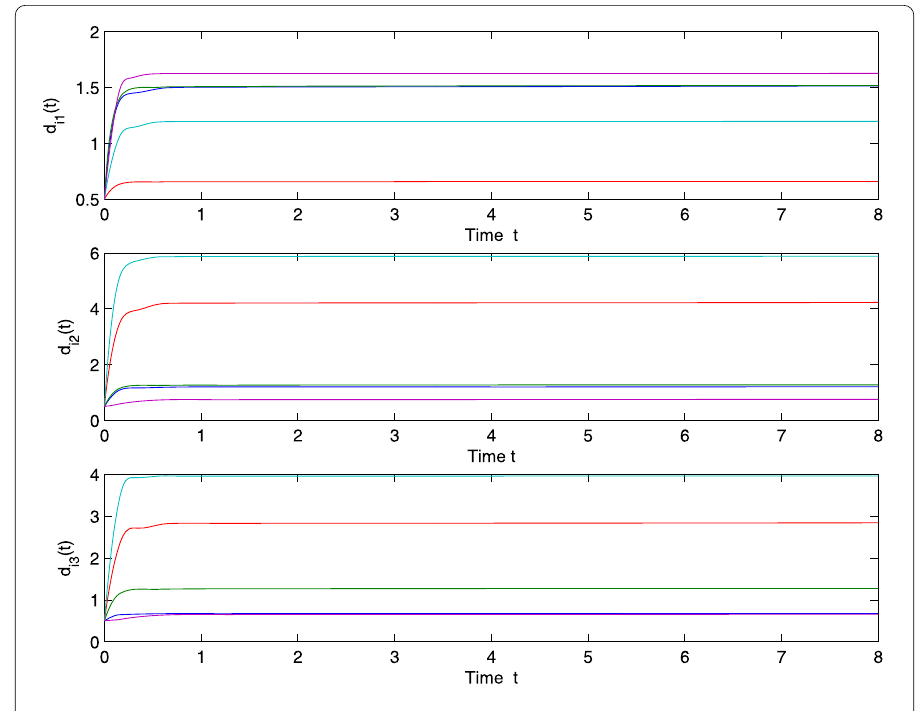
Figure 7 The evolution of adaptive feedback gain d i 1 ( t ), d i 2 ( t ) and d i 3 ( t ) ( i =